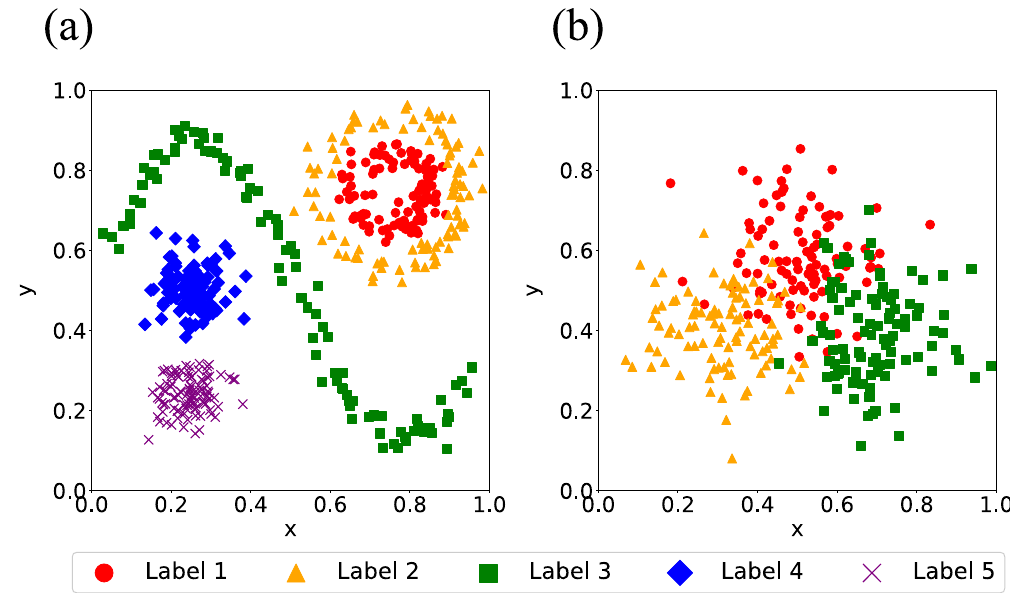
Figure 2. Distribution of artificial datasets used in Experiment 3. ( a ) Distribution of Artificial dataset 1. ( b ) Distribution of Artificial dataset 2.